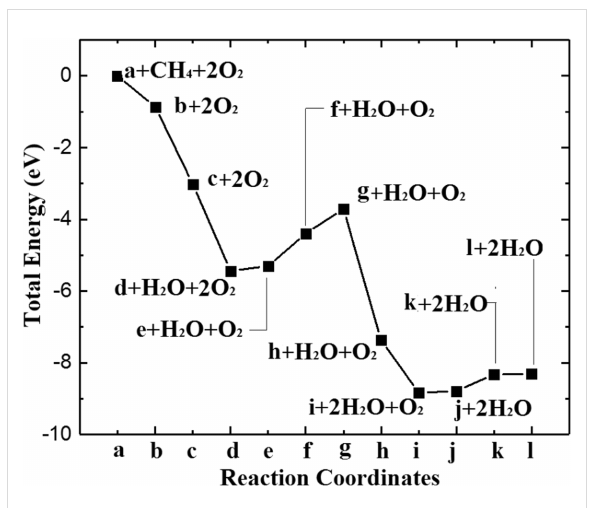
Figure 5: Energy profile for CH 4 oxidation. The geometries are shown in Figure 4.